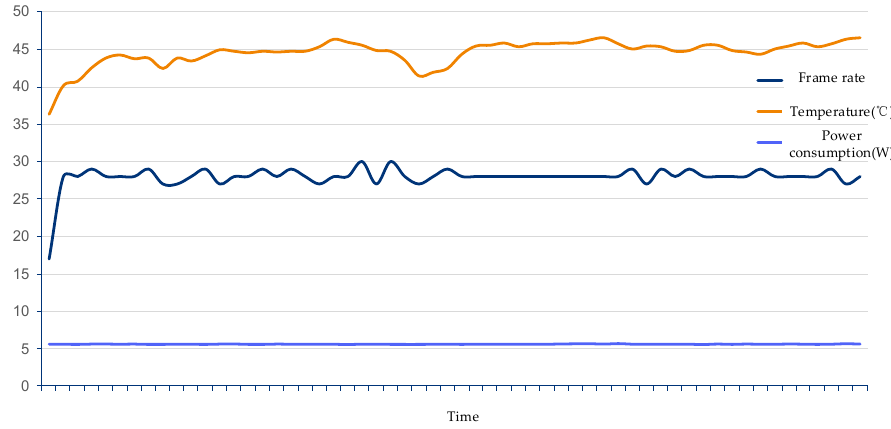
Figure 15. System operating status.